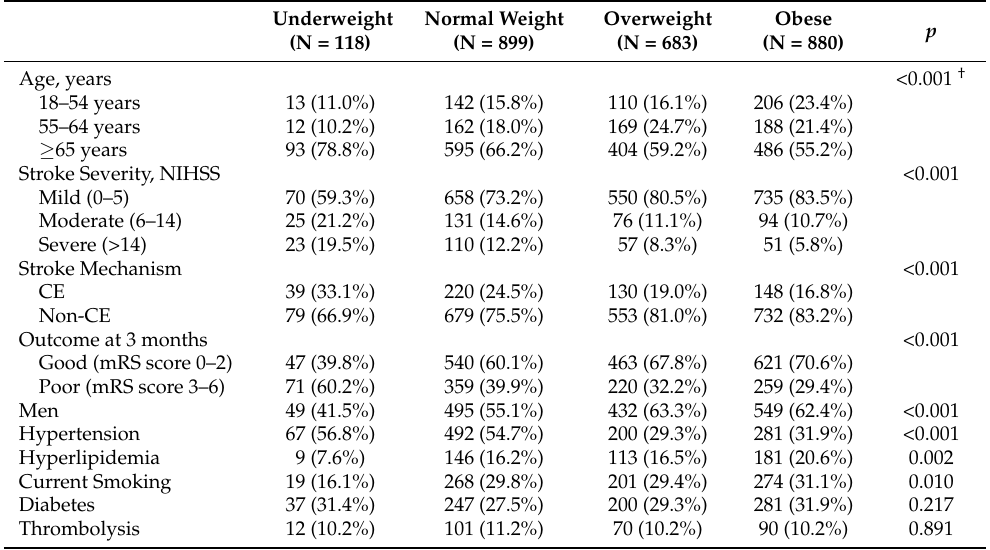
Table 4. Differences in clinical characteristics of the patients stratified by body mass